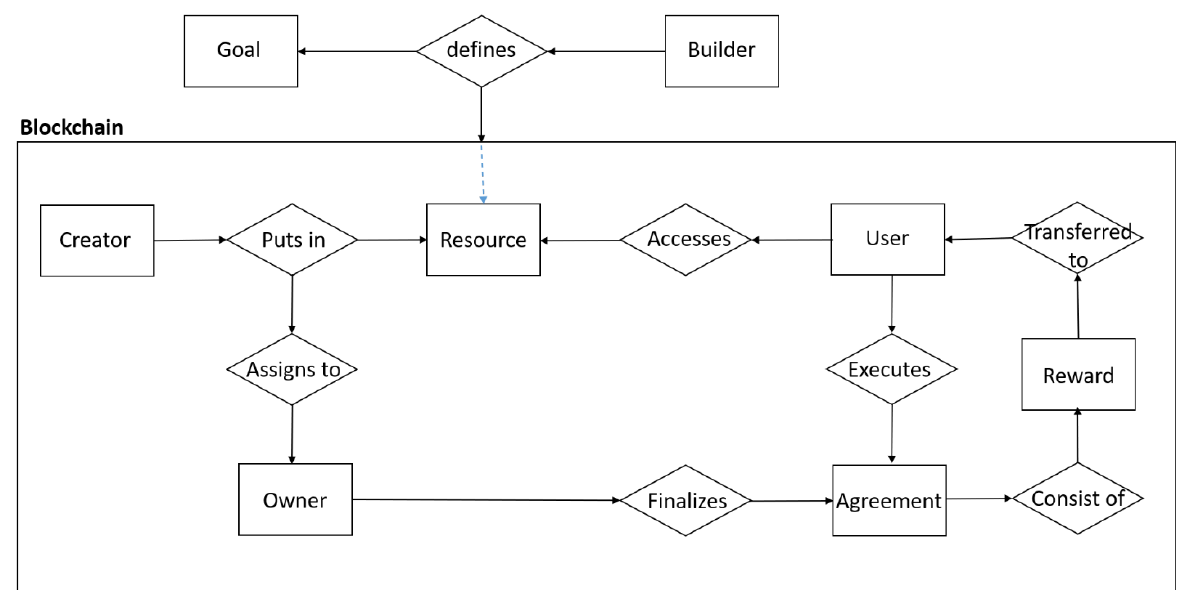
Figure 1. The conceptual model to align goals and share resources.